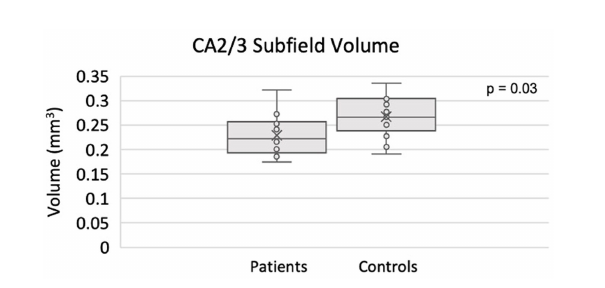
FIGURE 3 Smaller CA2/3 subfield volume in the right hippocampus of TRD patients compared to controls using